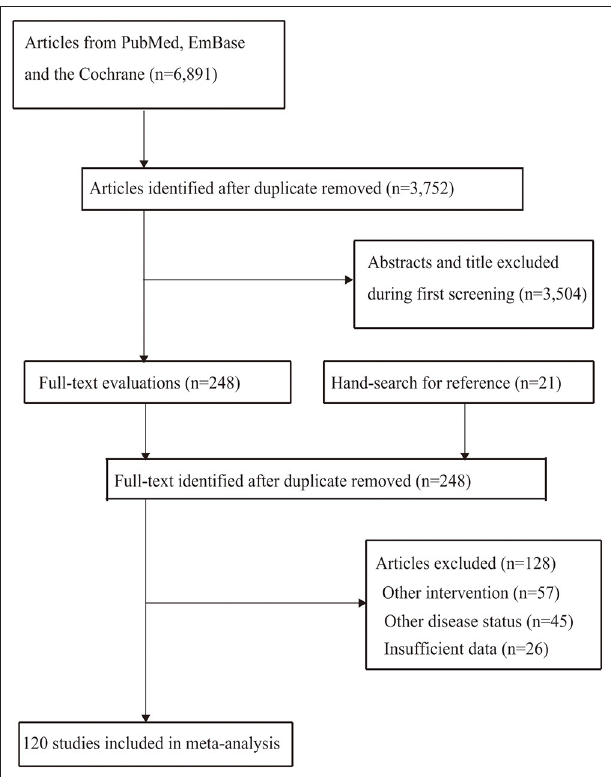
FIGURE 1 | PRISMA flowchart for process of literature search and study selection.